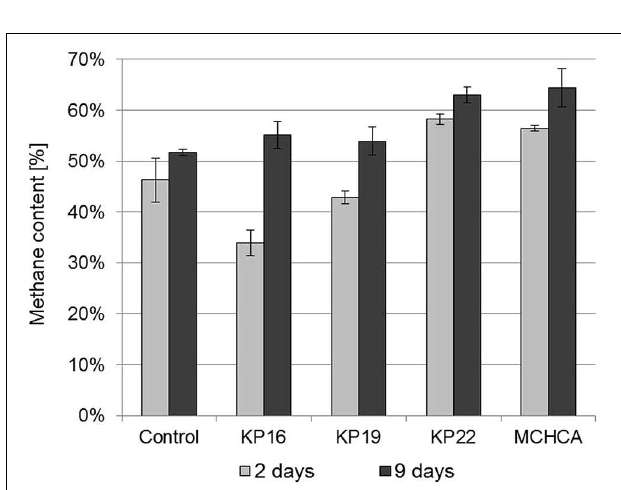
FIGURE 5 | The methane content in biogas during anaerobic digestion of maize silage – untreated and pretreated by the pure cultures and the MCHCA consortium.